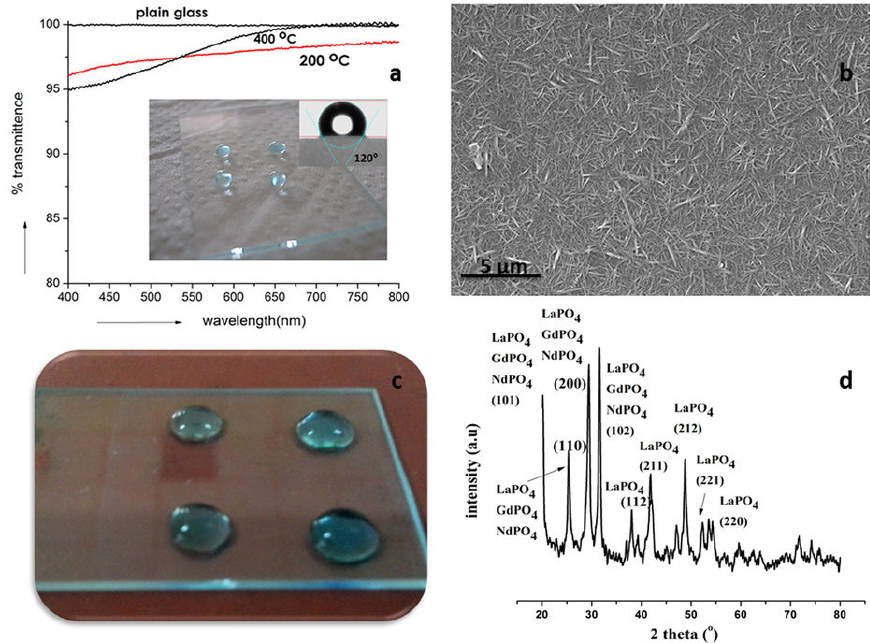
Figure 18. Hydrophobicity achieved for LaPO 4 coated thin film. ( a ) Water droplets sitting over LaPO4 coated glass plate and the high optical transparency recorded for the films; ( b ) SEM image showing spike ‐ like arrangement of LaPO 4 nanorods over the glass surface; ( c ) Mixed REP sol coated glass slide showing hydrophobic character; ( d ) Diffraction pattern obtained for mixed rare earth phosphates [46].